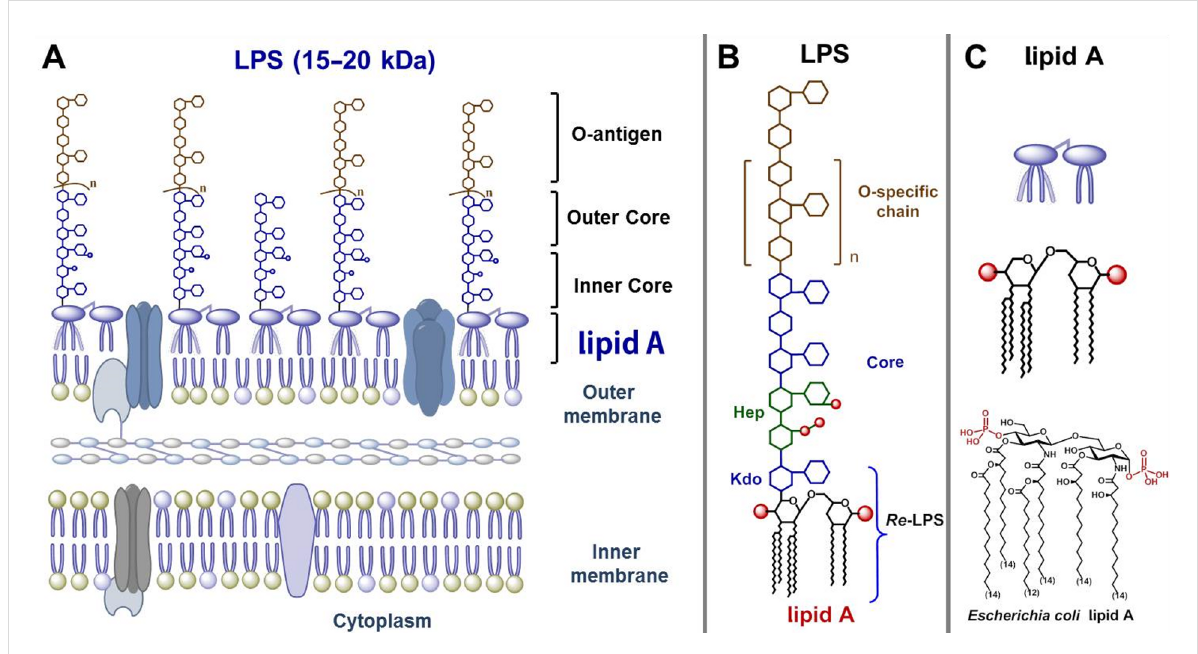
Figure 1: (A) Gram-negative bacterial membrane with LPS as major component of the outer membrane; (B) structural constituents of LPS: lipid A, inner/outer core and O-specific